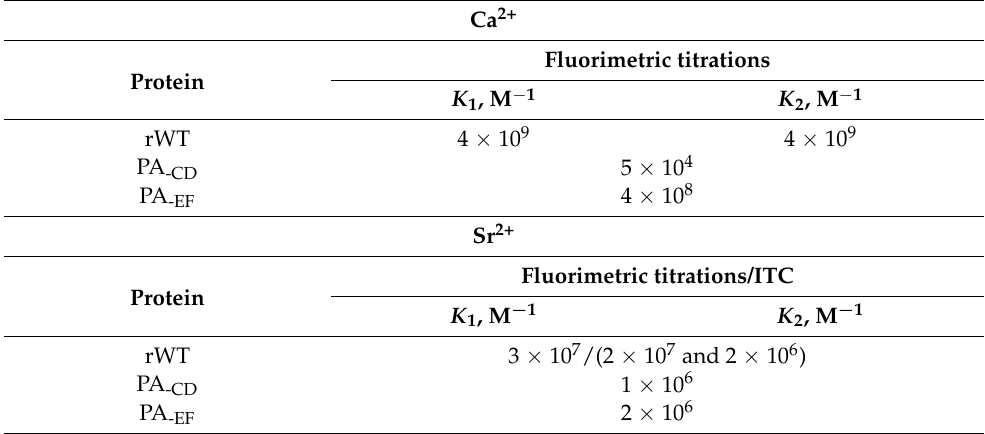
Table 1. The equilibrium Ca 2+ /Sr 2+ association constants for rWT α -PA and its mutant forms at 20 ◦ C, evaluated from the intrinsic fluorescence and ITC data, shown in Figures 1–3 (10 mM HEPES-KOH, pH